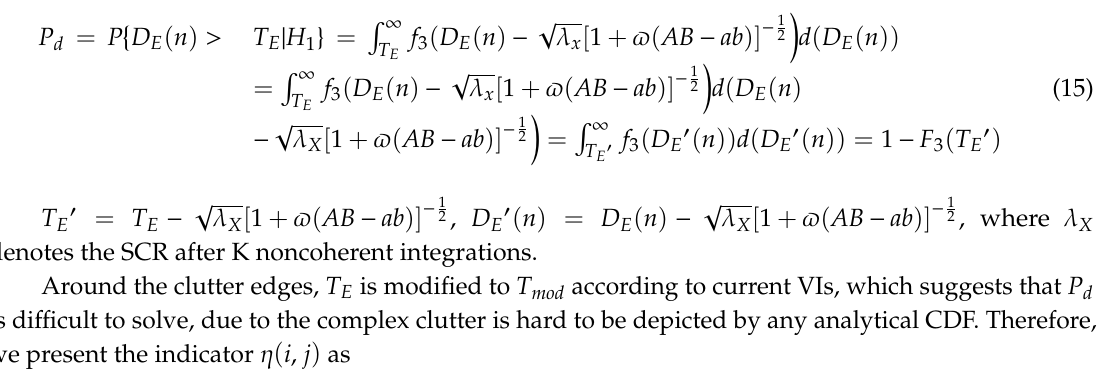
Figure 5. A veiled target near the sharp clutter edge is indicated by the modified threshold, which is intercepted from the homogeneous runway side when ( a ) 𝑉 𝑟𝑎𝑛𝑖 0 ,𝑗 0 (dB) < −𝜉 𝑟 or 𝑉 𝑎𝑧𝑖𝑖 0 ,𝑗 0 (dB) < −𝜉 𝑎 ; is intercepted from the homogeneous runway side when ( a ) V i 0 , j 0 ran ( dB ) < − ξ r or V i 0 , j 0 ( b ) 𝑉 𝑟𝑎𝑛𝑖 0 ,𝑗 0 (dB) > 𝜉 𝑟 or 𝑉 𝑎𝑧𝑖𝑖 0 ,𝑗 0 (dB) > 𝜉 𝑎 . ( dB ) > ξ a ( b ) V i 0 , j 0 ran ( dB ) > ξ r or V i 0 , j 0 azi